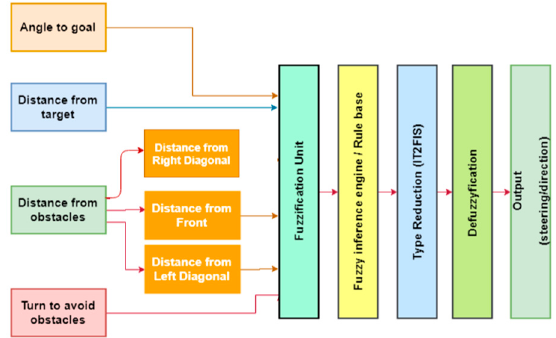
Figure 6. Block diagram of fuzzy-based robot path planning.